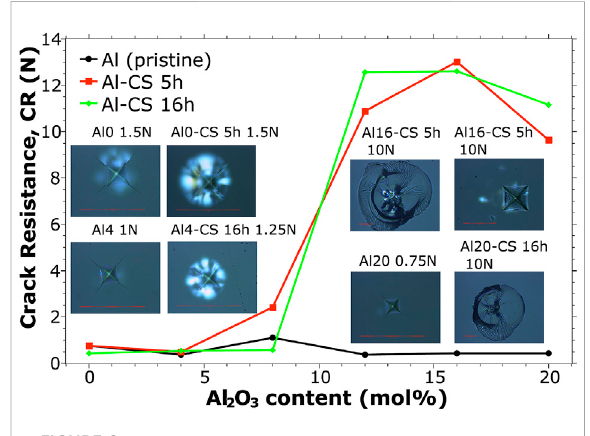
FIGURE 8 Crack resistance ( CR ) as a function of Al 2 O 3 content. The insets show some selected characteristic microscope light images of indents. The solid lines are guides for the